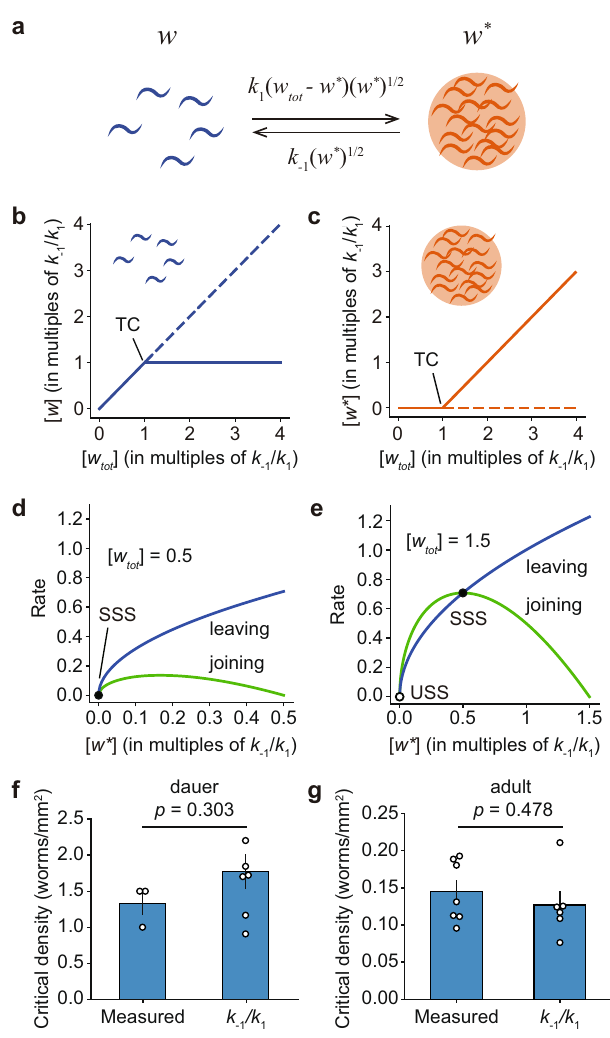
Fig. 4 A simple two-compartment model accounts for thresholded C. elegans colony formation. a Schematic of the rate equation model for colony formation. b , c The modeled steady-state densities of worms out of colonies ( w ), and in one or more colonies ( w* ), as a function of the total density of worms w tot , based on Eqs. 7 and 8. The system has a single stable steady state until the concentration of worms reaches a critical value of w tot = k − 1 / k 1 (TC, transcritical bifurcation point). Beyond the critical density, the system bifurcates, and has an unstable steady state (dashed) and a stable steady state (solid) with a constant density of the dispersed worms w . d , e Rate-balance analysis of a case with w tot smaller than the critical density ( w tot = 0.5 k 1 / k − 1 ), and one with w tot greater than the critical density ( w tot = 1.5 k 1 / k − 1 ). The joining (green) and leaving (blue) rates intersect at the steady states. In d , the single steady state with w* = 0 is stable (SSS), as small perturbations make leaving occur faster than joining, making the system return toward the steady state. In e , the steady state at w* = 0 is unstable (USS), as small perturbations would make joining occur faster than leaving, and drive the system away from that steady state. f , g Critical density of dauer worms ( f ) and adult worms ( g ) measured directly as in (Fig. 1e, g) (mean ± S.E.M.; n = 3 for dauer and n = 7 for adult) and compared to predicted critical density values obtained by measuring k − 1 and k 1 from time-lapse movies of dauer-stage worms ( n = 7) or adult worms ( n = 6) (not necessarily at steady state). Measurements were taken from distinct samples. The p values were calculated using student ’ s t -test (two-sided, Shapiro normality test failed to reject